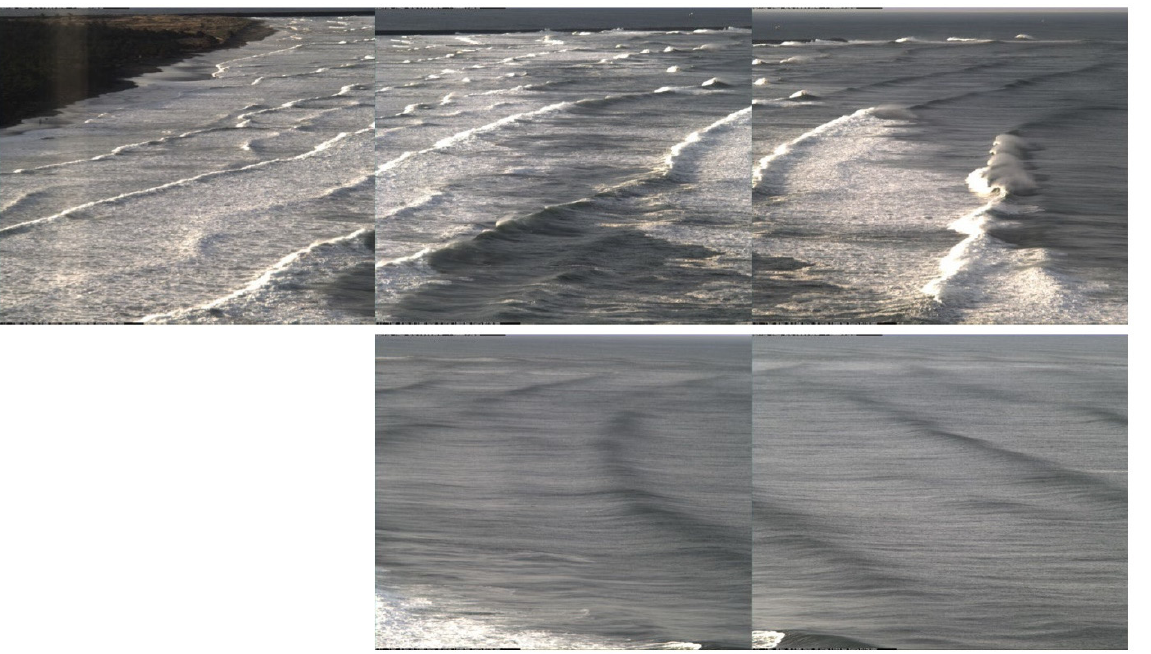
Figure 2. Example snapshots from each of the five cameras from North Head for 12 March 2018, 1530